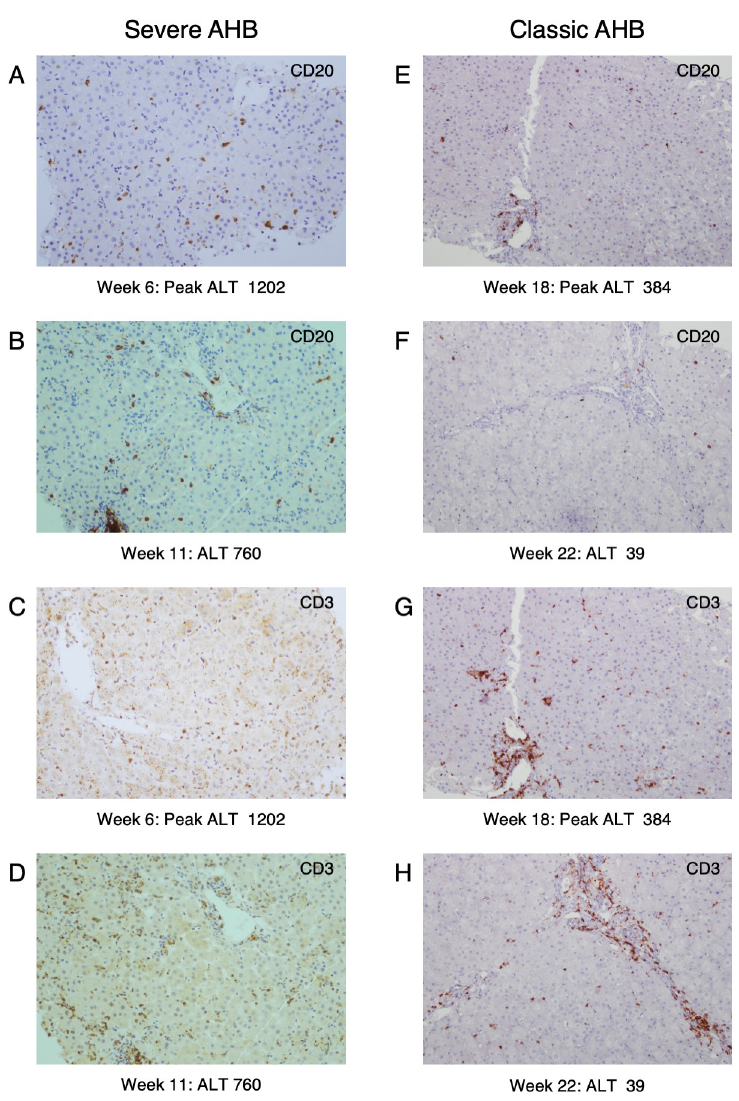
Fig 3. Comparison of immunohistochemical staining of B-cell and T-cell lineages in liver sections of representative chimpanzees with severe and classic acute hepatitis B (AHB) at different time points. Liver sections were stained with antibodies specific for B cells (CD20) (A and B) and T cells (CD3) (E and F). Infiltration of B cells, as single cells (A) or organized in clusters in the portal areas (B), was more extensive in severe than in classic AHB (E and F). In CH1410 with severe AHB (C), T cells at the time of the ALT peak were distributed as single cells within the lobule whereas in classic AHB (G), T cells were more abundant and were present both as single cells in the lobule and as clusters in the portal areas. T cells became more numerous after the ALT peak in severe AHB (D) and remained detectable during the resolution phase in classic AHB (H). The images of CH5835 regarding the histopathology, CD20 and CD3 staining were previously reported